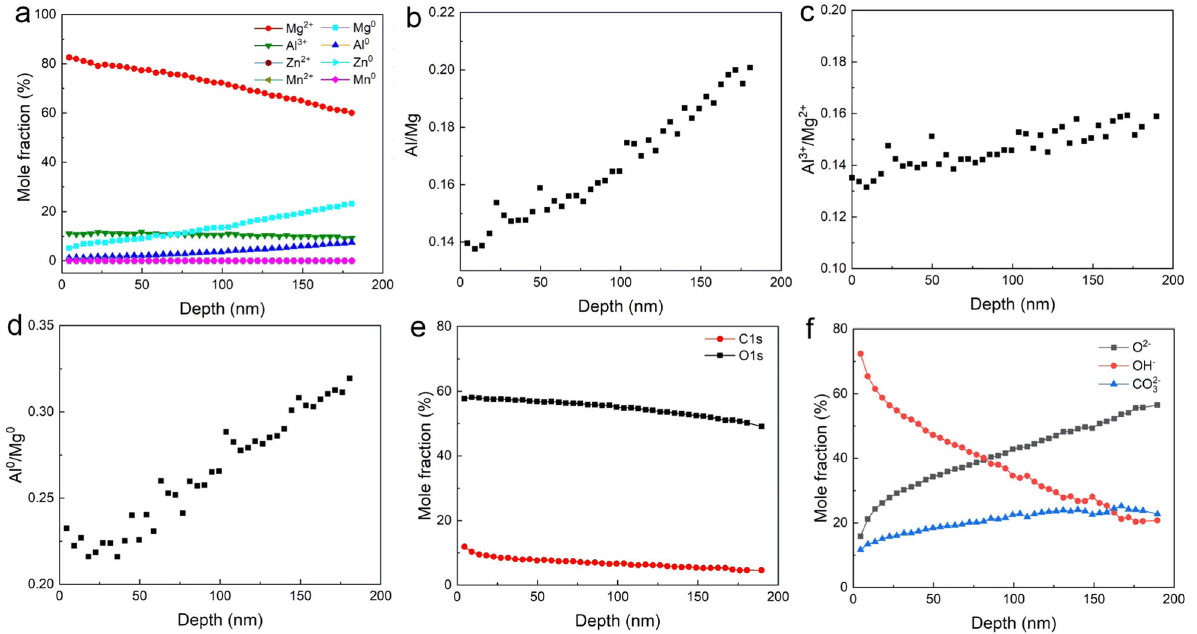
Fig. 4 XPS analysis of elemental distribution of air-exposed surface. XPS measurements revealing ( a ) fraction of each cation and elemental metal, ( b ) Al/Mg ratio, ( c ) Al 3 + /Mg 2 + ratio, ( d ) Al 0 /Mg 0 ratio, ( e ) ratio fraction of O and C among metallic and non-metallic element, and ( f ) fraction among O 2 − , OH − , and C O 2 (cid:1) 3